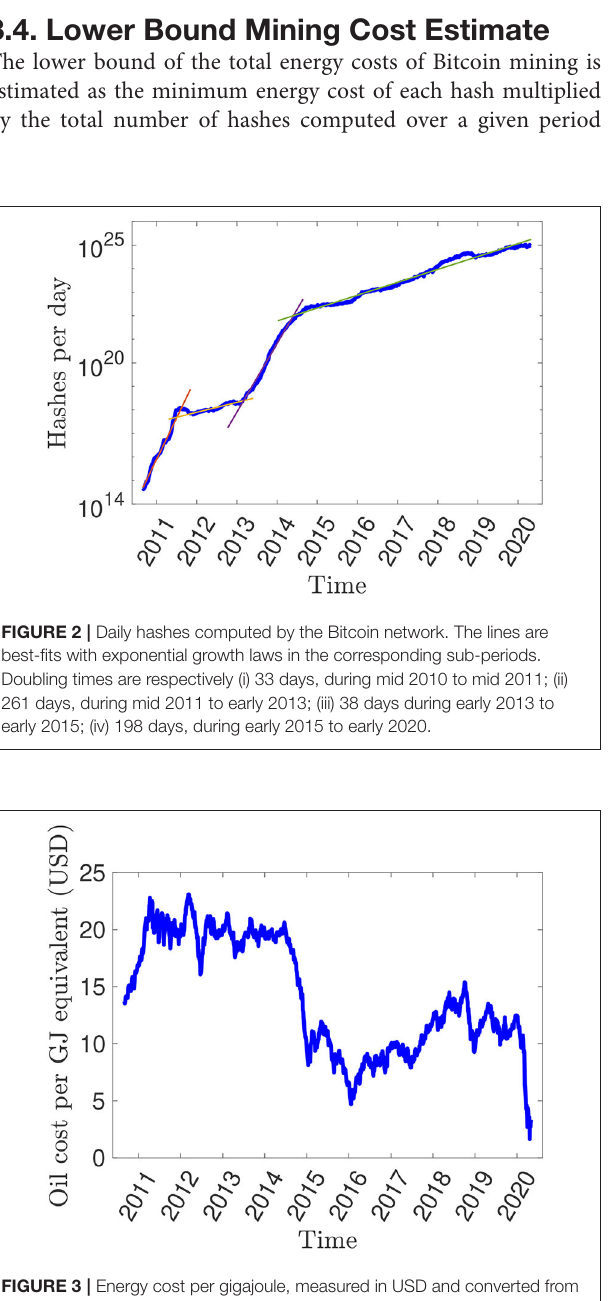
Frontiers in Blockchain |